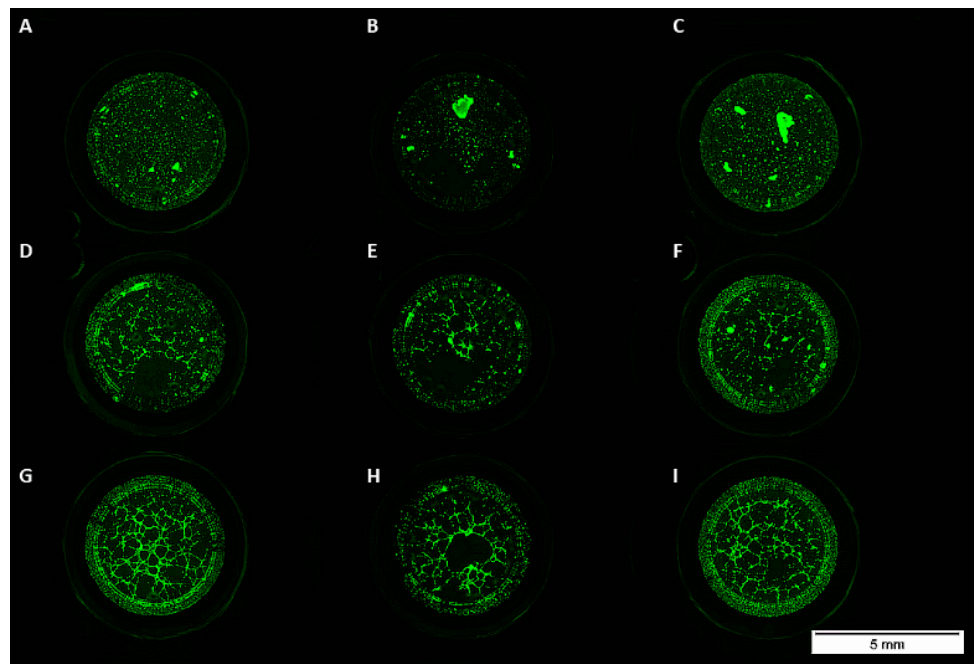
Figure 3. Monocultured ADSCs treated with or without BMP2 or VEGFA165 formed no tubes in ma-